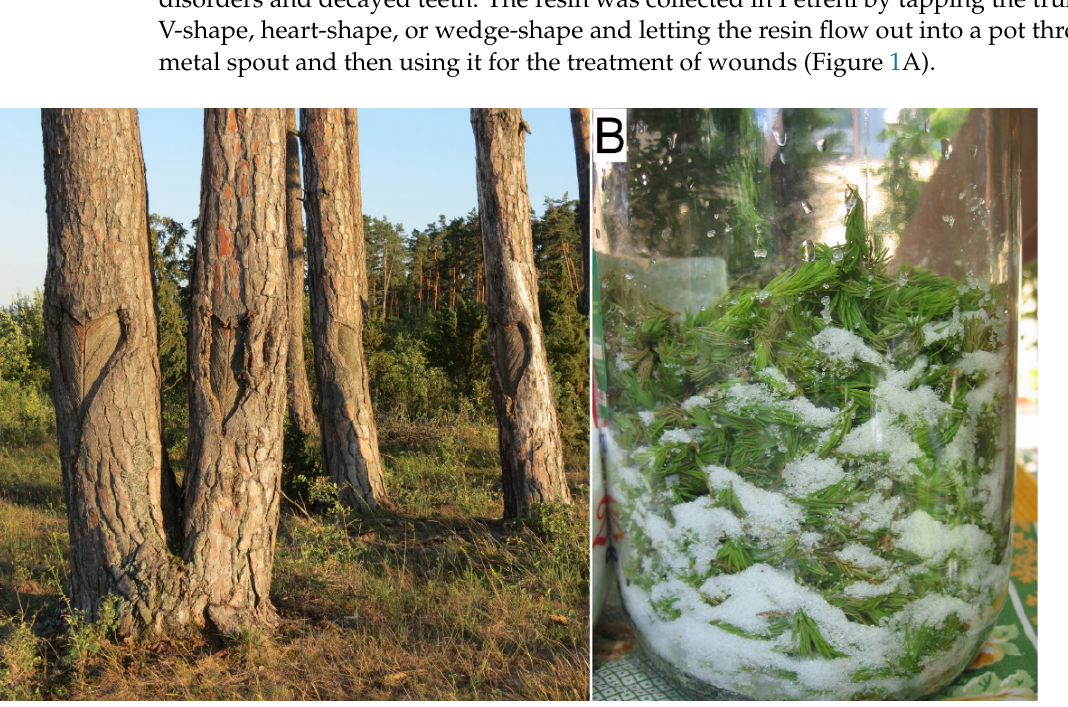
Figure 1. ( A ) Resin collection by tapping the trunk (in Petreni) and ( B ) Preparation of syrup from the young shoots (in Lueta) .